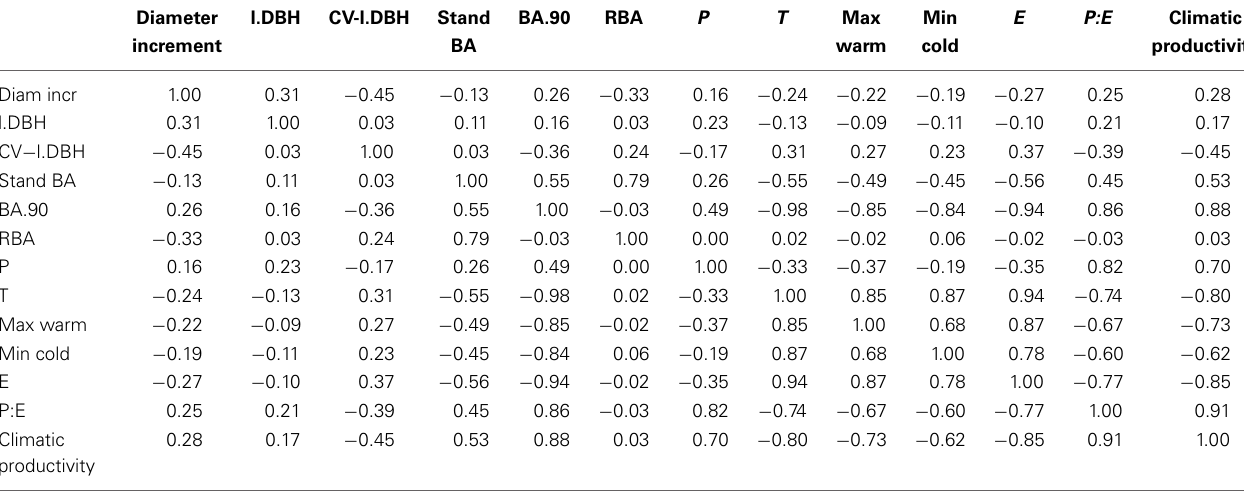
Table 2 | Correlation matrix for growth, tree size, climatic, and competition variables.